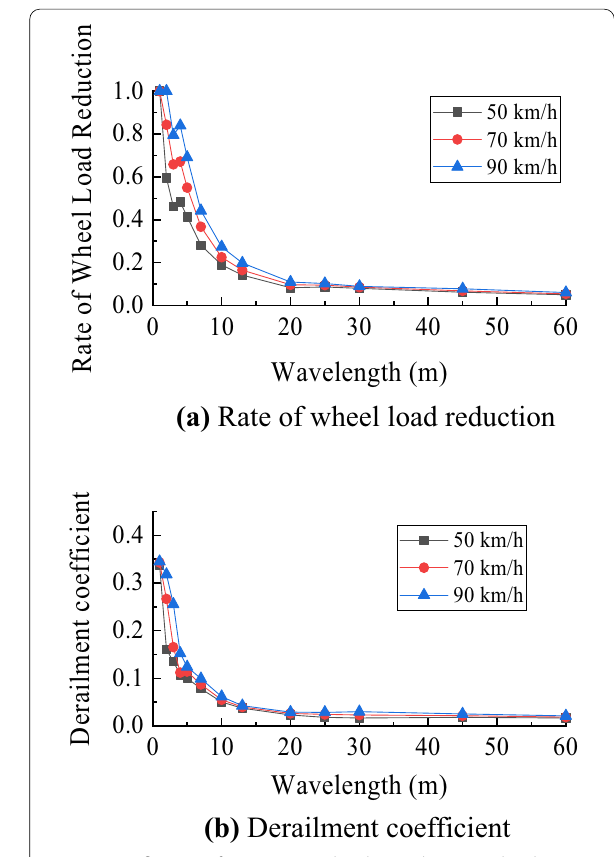
Figure 8 Influence of 10 mm cross-level irregularity amplitude on the rate of wheel load reduction and derailment